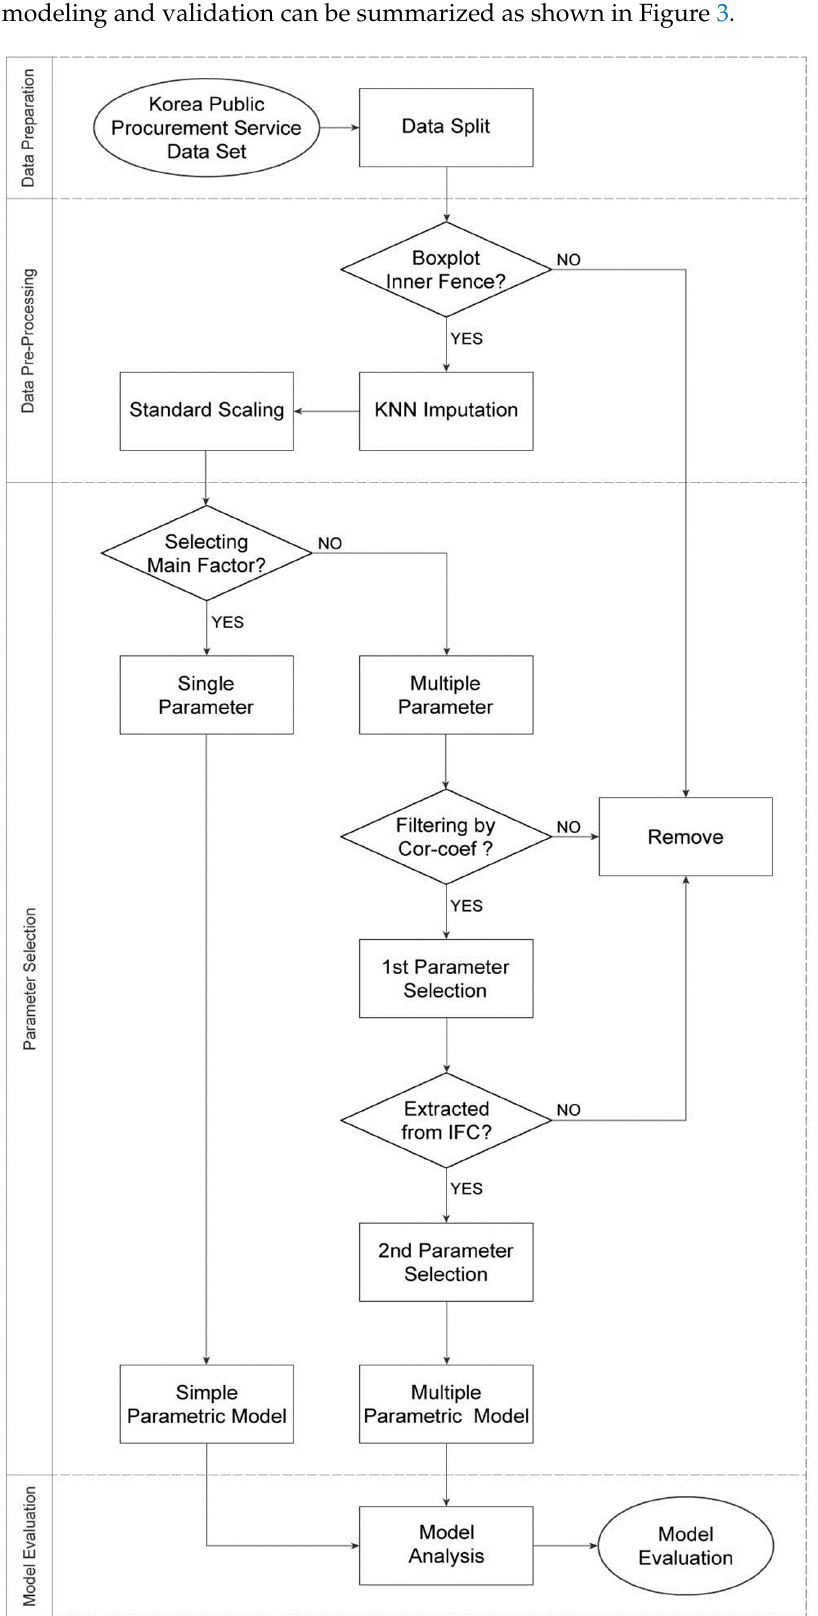
Figure 3. Cost prediction modeling process.